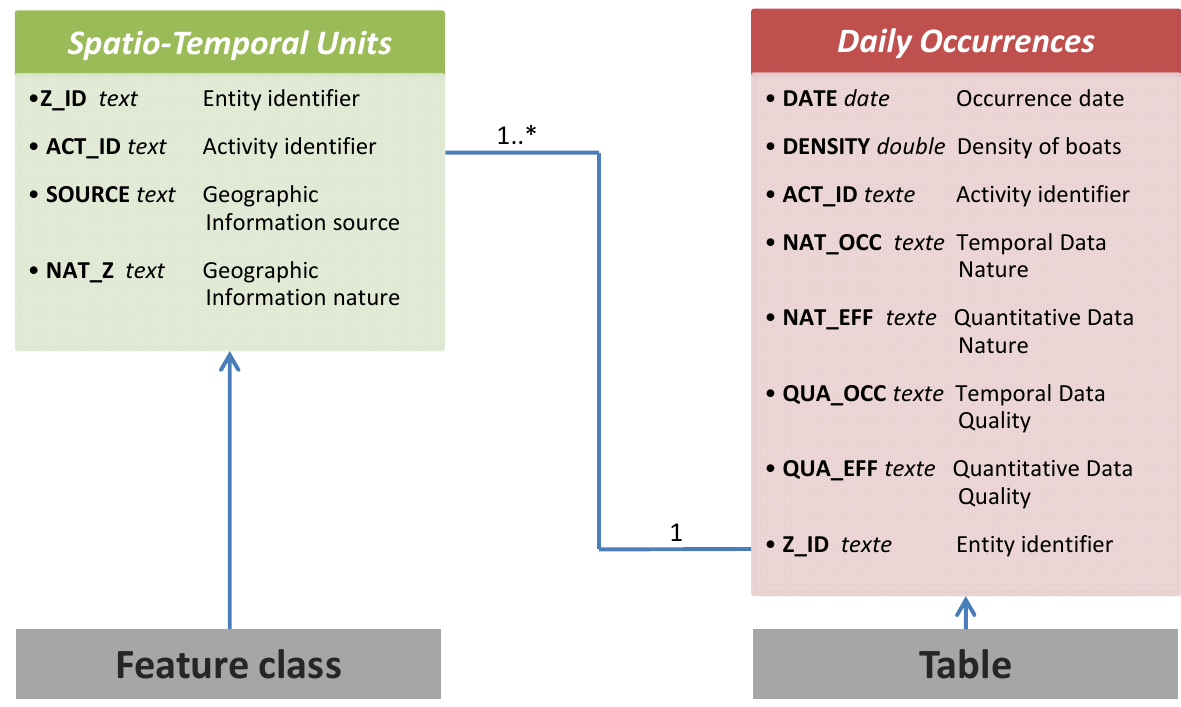
Figure 2. Spatio-temporal database